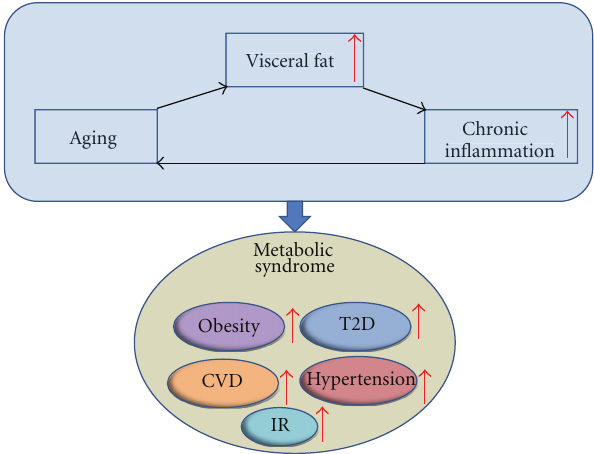
Figure 3: Link between Aging, visceral fat, inflammation, and metabolic syndrome. Visceral fat increases with age and the increase of visceral fat induces inflammation. Inflammation accelerates the process of aging. The vicious cycle of aging, visceral fat and inflammation increases the risk of metabolic diseases such as obesity, IR, T2D, CVD, and hypertension, CVD: cardiovascular disease, IR: insulin resistance, T2D: type 2